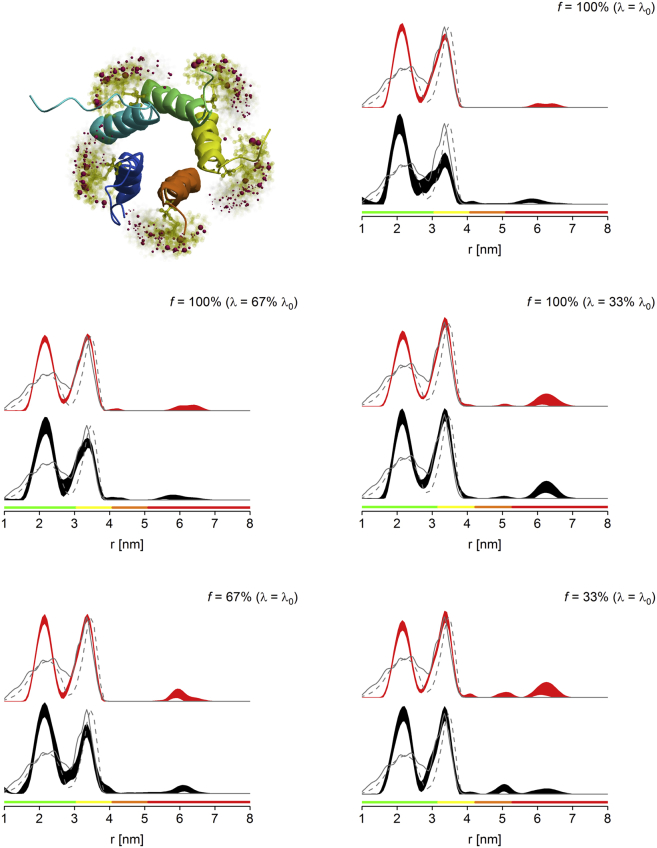
MscL V120R1 PELDOR distance distributions obtained for fully labeled protein at Q-band (top right), λ-reduced fully labeled protein (middle panel, left, λ = 67% λ0; right, λ = 33% λ0), and sparsely labeled protein (bottom panel, left, f = 67%; right, f = 33%). See Fig. 1 for details on the 2σ confidence intervals, predicted distance distributions, and color bars. See Supporting Material for raw PELDOR data and processing. (Top left) Shown here is the MMM model of fully labeled cytosolic domain of E. coli MscL protein. To see this figure in color, go online.